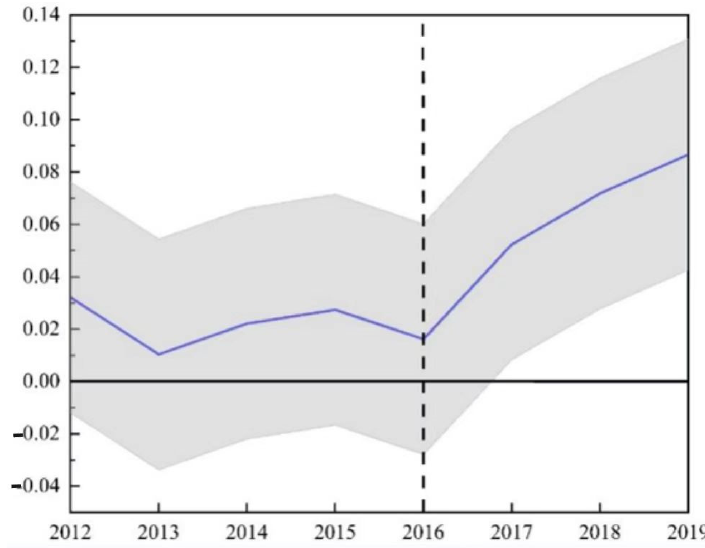
Figure 3. Parallel trend